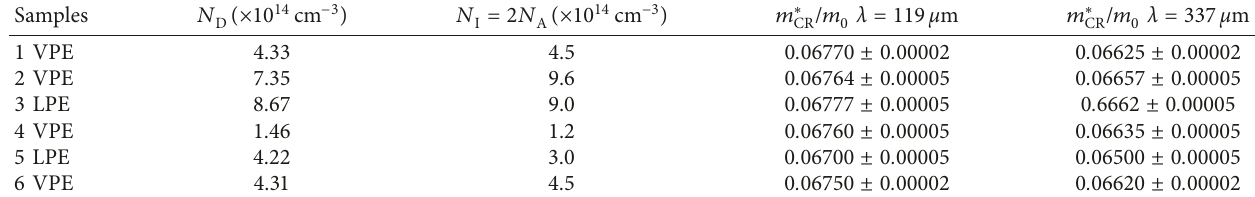
Table 2: Effective masses of n-GaAs samples under investigation for the radiation wavelengths λ � 119 μ m and λ � 337 μ m.